Question: According to the figure, is the described quantity increasing or decreasing?
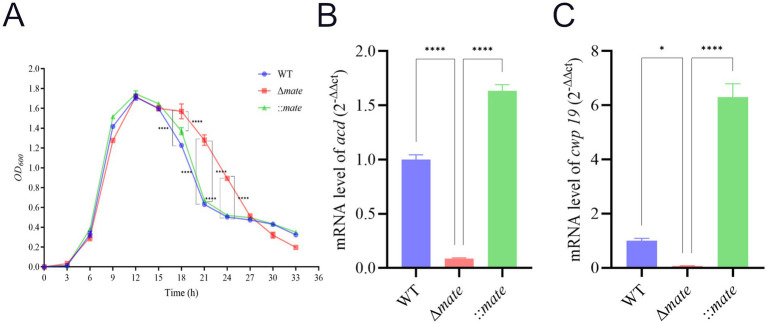
Answer: increasing